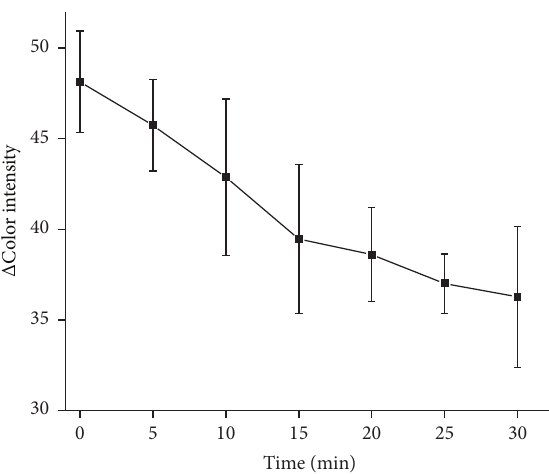
Figure 4: Optimization of pH strip incubation time with ATChCl as a substrate. Error bars represent standard error of the mean for 𝑛 =